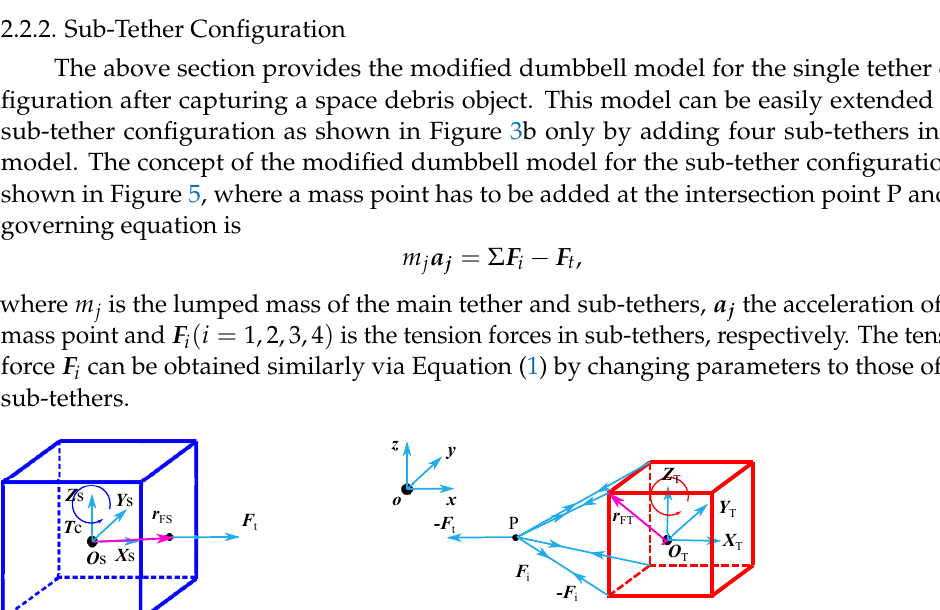
Figure 4. Concept of the modified dumbbell model.